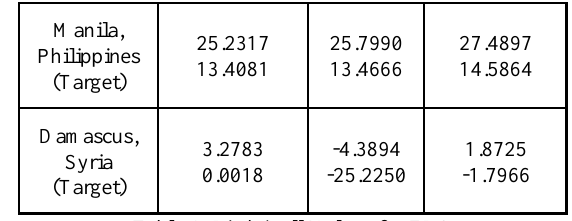
Table 1. Pitch/Roll Values for ERC